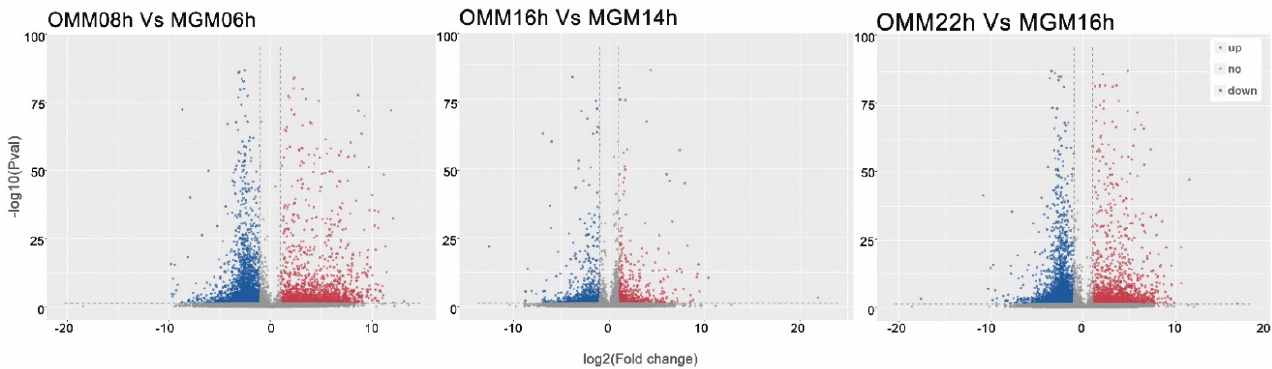
Figure 3. Volcano plot of differentially expressed genes at different time points. Red represents genes that are significantly different and upregulated; blue represents genes that are significantly different and downregulated; gray represents genes that are not significantly different.